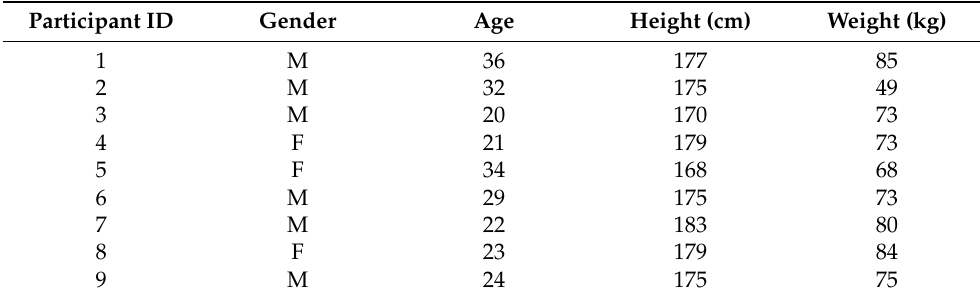
Table 1. Participants’ demographic